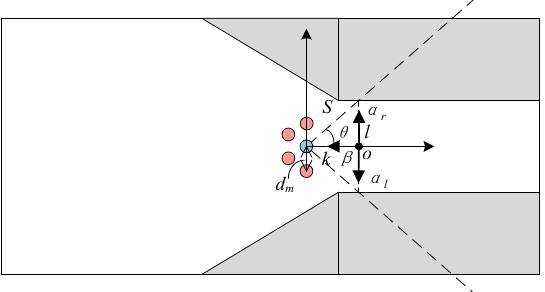
Figure 7. The impact of narrowed road boundaries on the UGVs fleet.